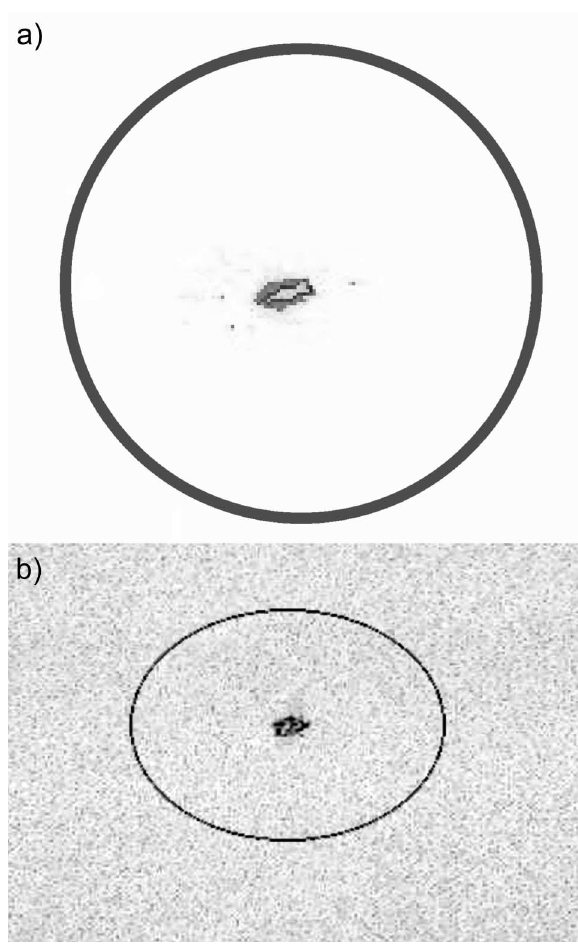
FIG. 15. Images of the phosphor screen taken (a) at the loca- tion where the Ta aperture is placed and (b) a meter downstream from the Ta aperture. The circles represent the edge of the phos- phor screen which is 19 mm in